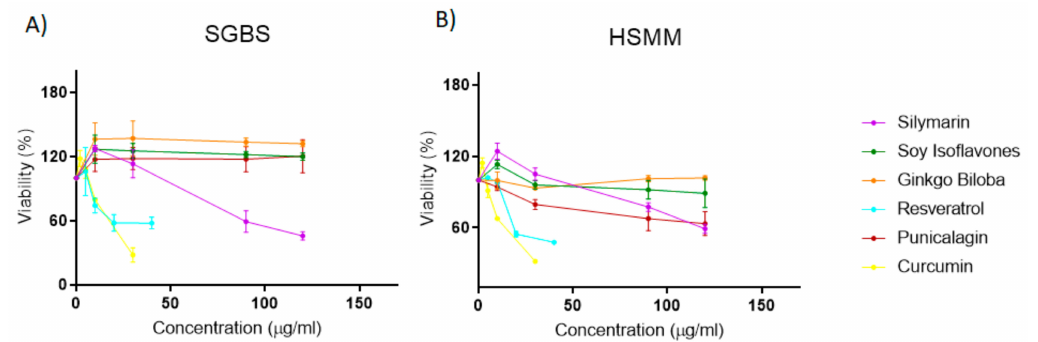
Figure 3. Effect of the extracts on cell viability (MTT assay) of ( A ) proliferating human pre-adipocytes (SGBS) and ( B ) proliferating human myoblasts